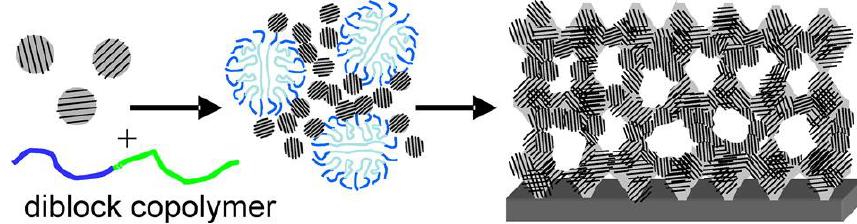
Figure 14. Schematic illustration for the preparation of porous metal oxides by using the evaporation induced self-assembly (EISA) of a dispersion consisting of diblock copolymers and inorganic particles in the first step followed by thermal treatment. By this general methodology mesoporous ceramics can be obtained (reprinted with permission from reference [267]; Copyright 2012 American Chemical Society).